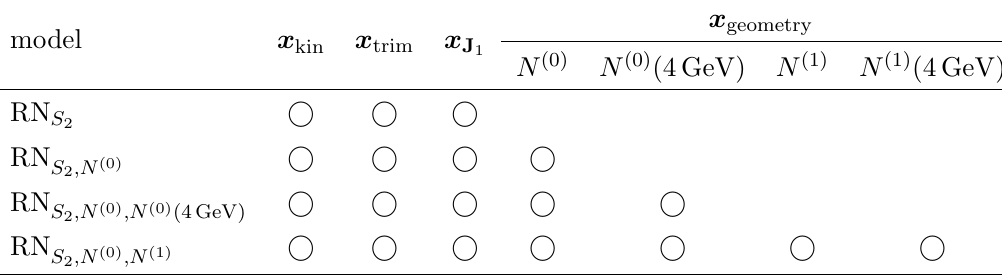
Table 1. The list of inputs used in each RN. The circle represents that the given input is